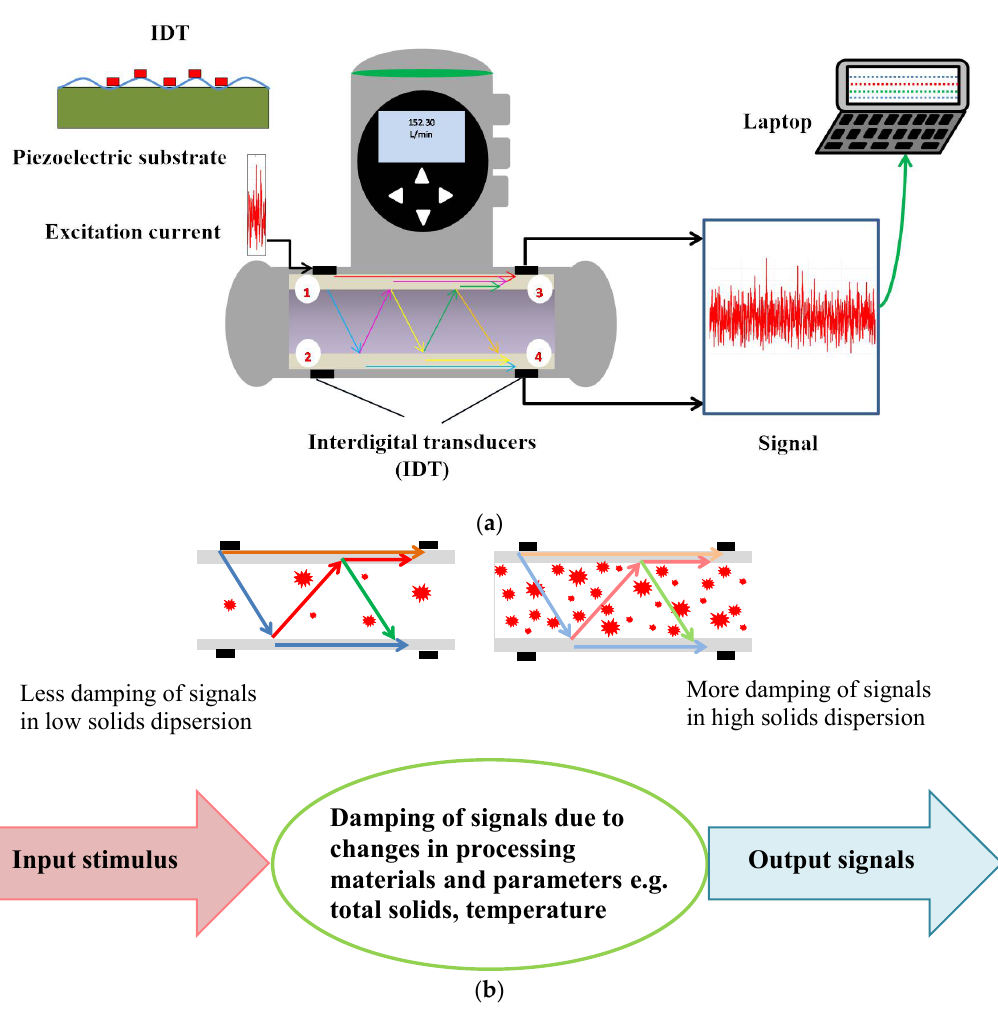
Figure 1. ( a ) Schematic representation and working principle of the acoustic flowmeter (FLOWave) (numbers represent four interdigital transducers). ( b ) Schematic of signals damping in low solids and high solids dispersion, arrows represent the direction of the travelling acoustic signals within the FLOwave acoustic flowmeter. The intensity of the colour of the arrow decreases as the solids content increases indicating dampening of the signals occurring.